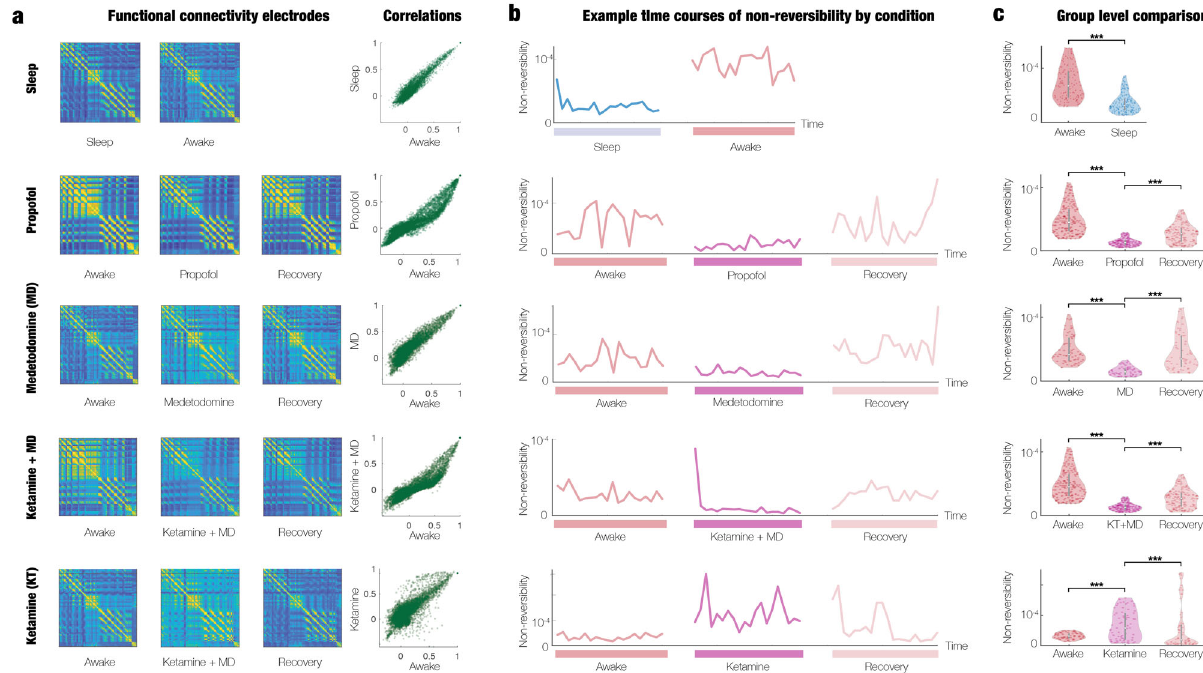
Fig. 3 Estimating the arrow of time in brain signals provides signi fi cantly different signatures of brain state. The fi gure summarises the results of analysing all the available (eyes closed) data from the non-human primates in sleep and four different states of anaesthesia (see Methods and Fig. 2). a The column shows individual examples of the functional connectivity matrices across the 128 electrodes and a scatter plot of the correlation between each condition. As can be seen, this conventional method is unable to distinguish between the very different brain states. b In contrast, the central panel shows the application of the thermodynamic framework of estimating the arrow of time on the same individual time series, which is clearly distinguishing brain states. c The column shows the signi fi cant group level results (across all non-human primates with all sessions belonging to the speci fi c brain state) which provides a clear signature able to distinguish between different brain states (Wilcoxon rank-sum, p <